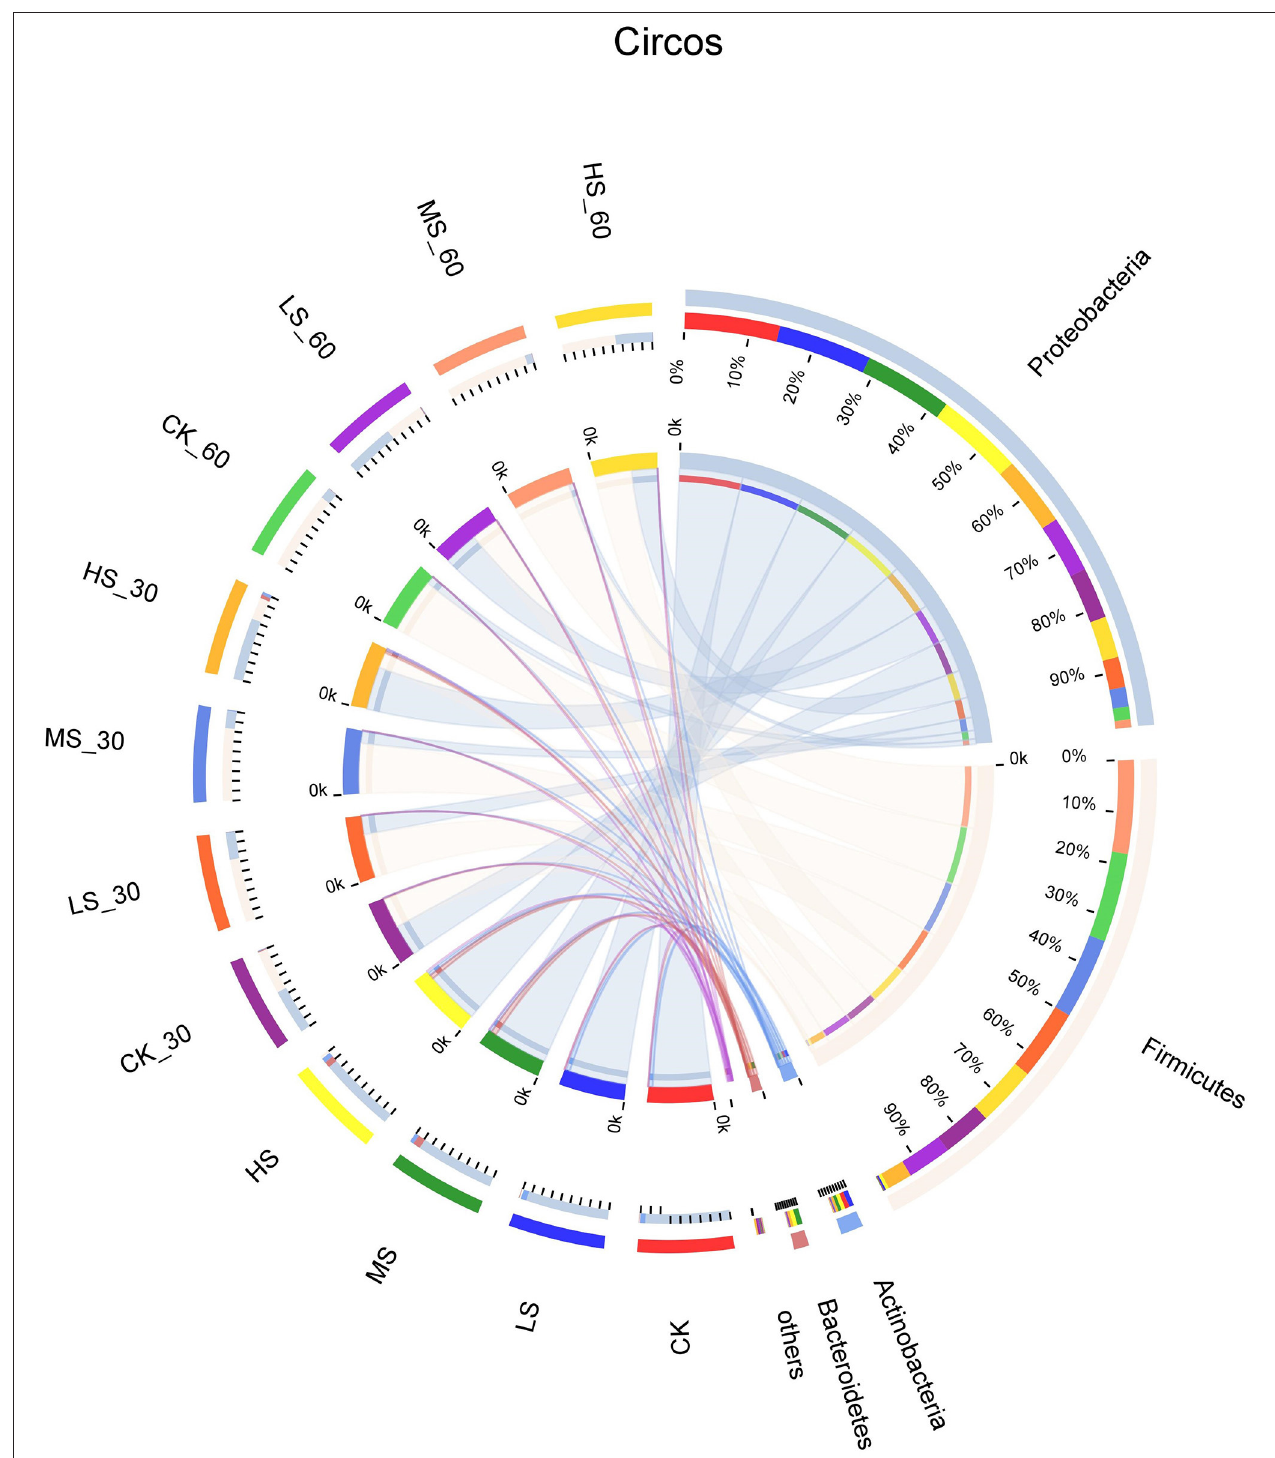
FIGURE 1 | Differences in relative abundance of microbial community on phylum level shown by using a Circos plot. The size of the bars from each phylum shows the relative abundance of that phylum in the sample. CK, fresh material of alfalfa without salt stress; LS, alfalfa under light salt stress; MS, alfalfa under moderate salt stress; HS, alfalfa under severe salt stress; 30, 30 days of ensiling; 60, 60 days of ensiling.